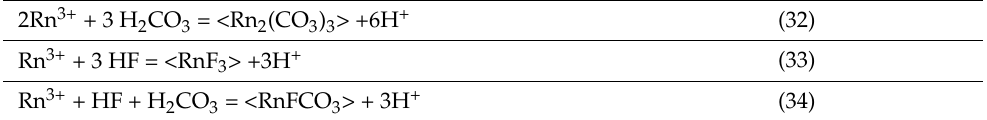
Table 8. Precipitation equations of Rn 3+ into various precipitants used in Figure